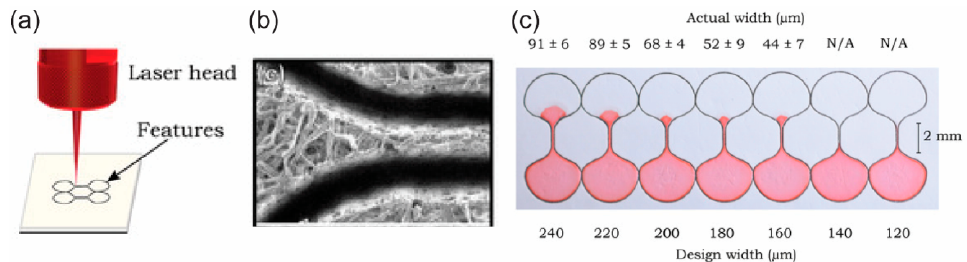
Figure 3. Cutting and shaping paper in the fabrication of p-CMF devices. ( a ) The use of a laser beam to cut and shape paper to form a large paper channel, ( b ) SEM image of the paper channel formed by using the laser, and ( c ) prepared p-CMF devices with various channel widths. Reproduced with permission from the authors of [20]. Copyright 2018 under the terms and conditions of the Creative Commons Attribution.